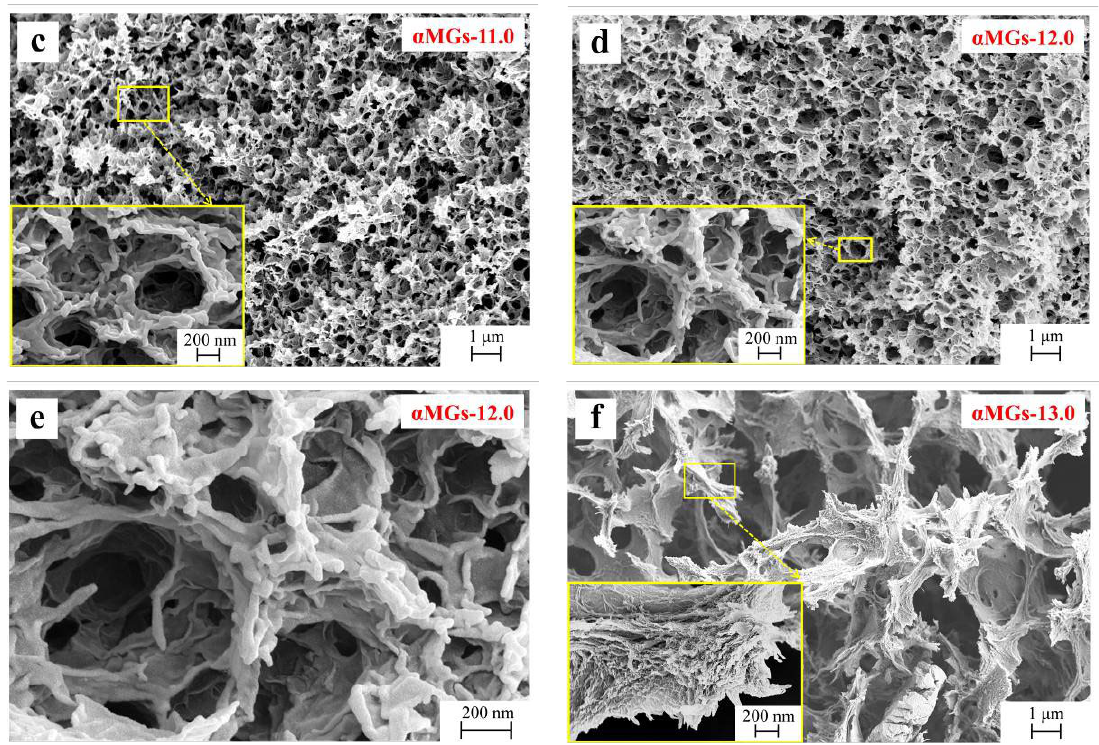
Figure 3. High- magnification SEM images of αMGs -X samples at different hydrothermal pH levels.